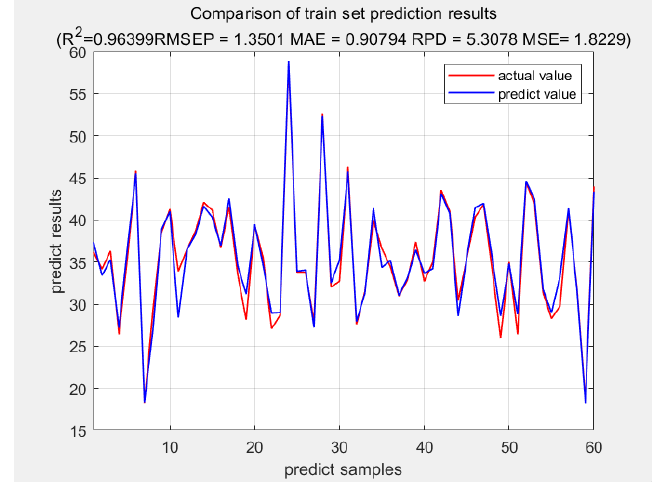
Figure 10. Actual value and predict value in train set.